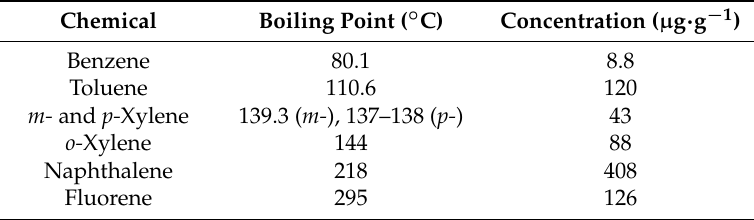
Table A6. Volatile aromatic hydrocarbon concentrations in heavy fuel oil from the Nakhodoka tanker